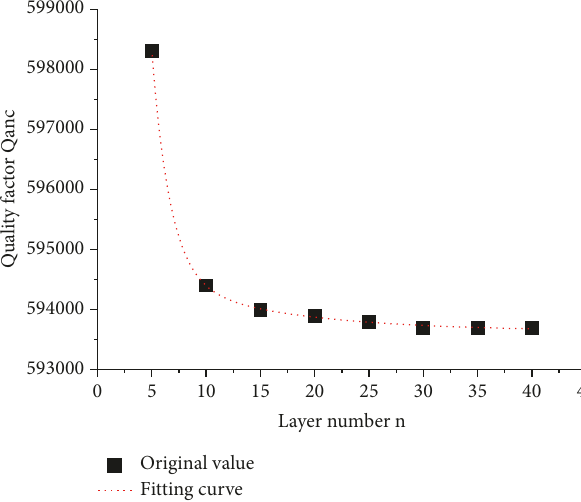
Figure 6: Estimated Q versus sweeping layer number n anc